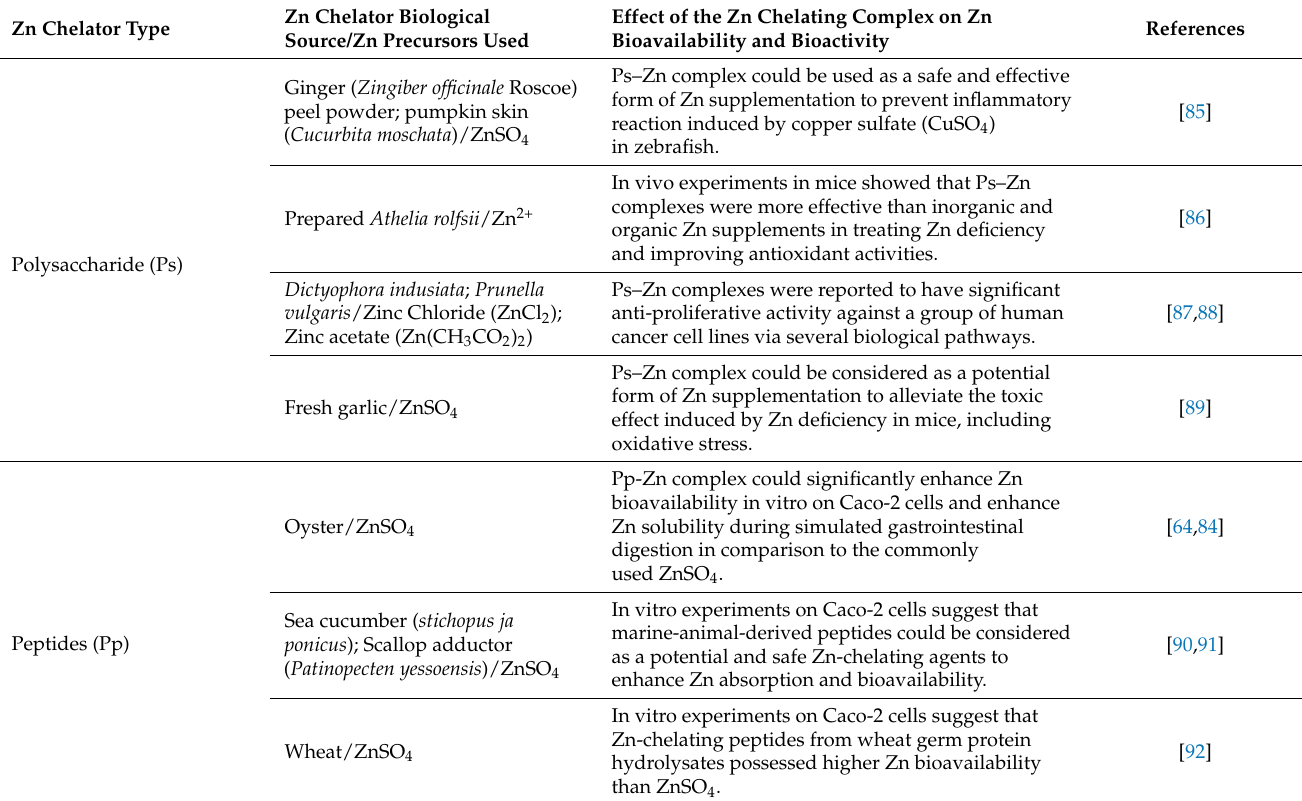
Table 1. Recently reported zinc-chelating biological agents and their effect on zinc bioavailability and